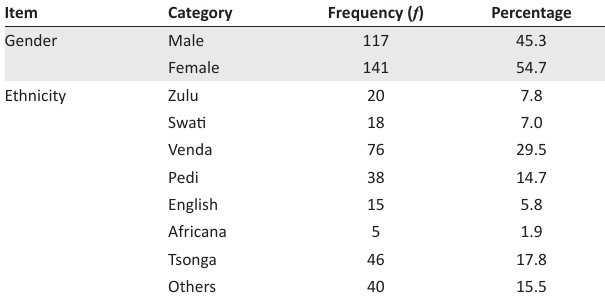
TABLE 3: Demographic profile of the respondents.